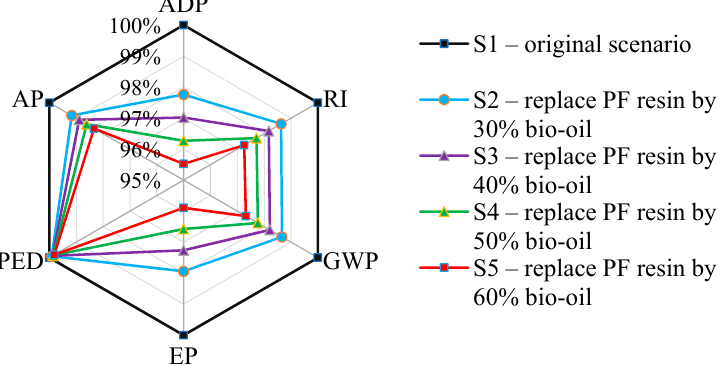
Figure 4. Sensitivity analysis for reducing consumption of phenolic formaldehyde (PF) resin.